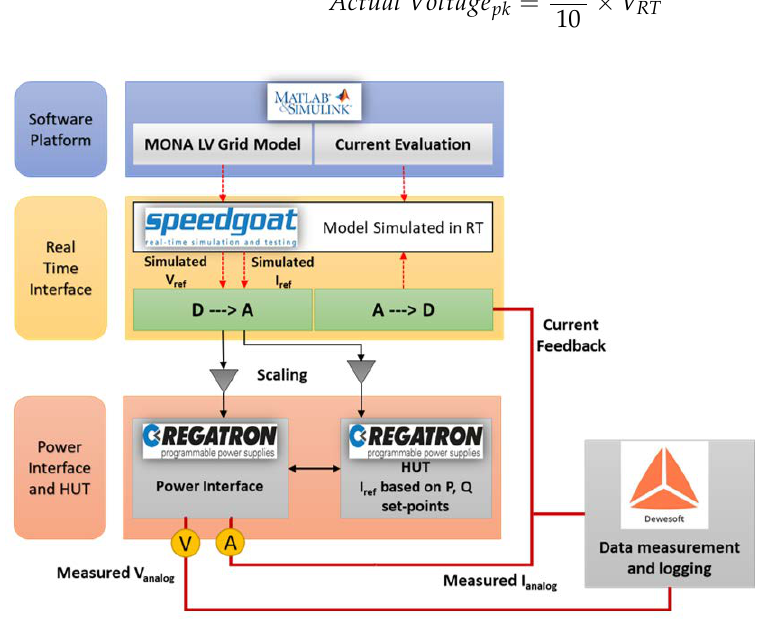
Figure 7. PHIL simulation environment illustrated with the components, data acquisition, and feed- back